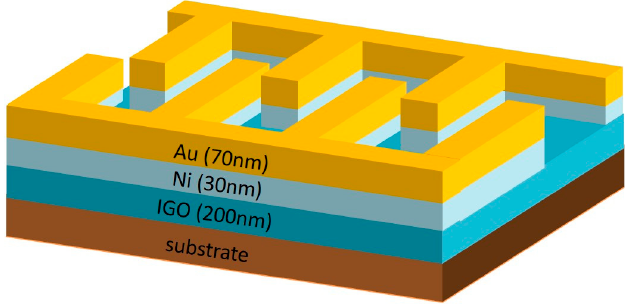
Figure 1. Schematic structure of a metal–semiconductor–metal (MSM) photodetector.